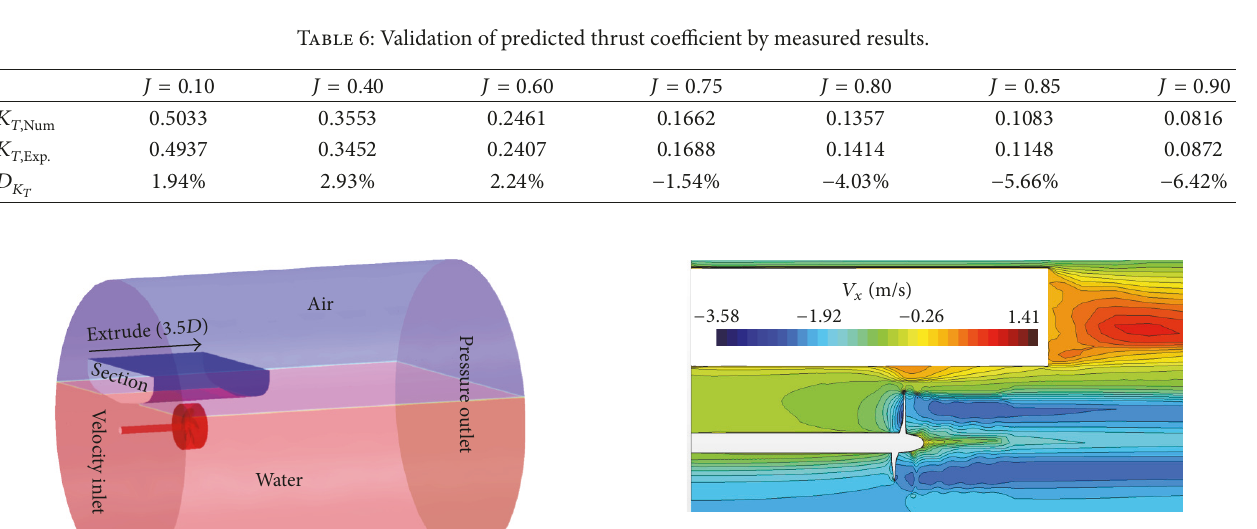
Figure 19: Axial velocity contour near the rotating propeller.